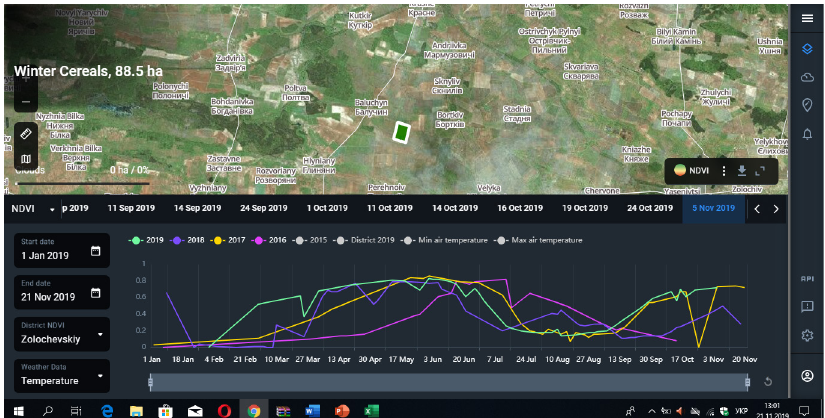
Figure 6. Dynamics of NDVI in winter cereal cultivation for model land use during